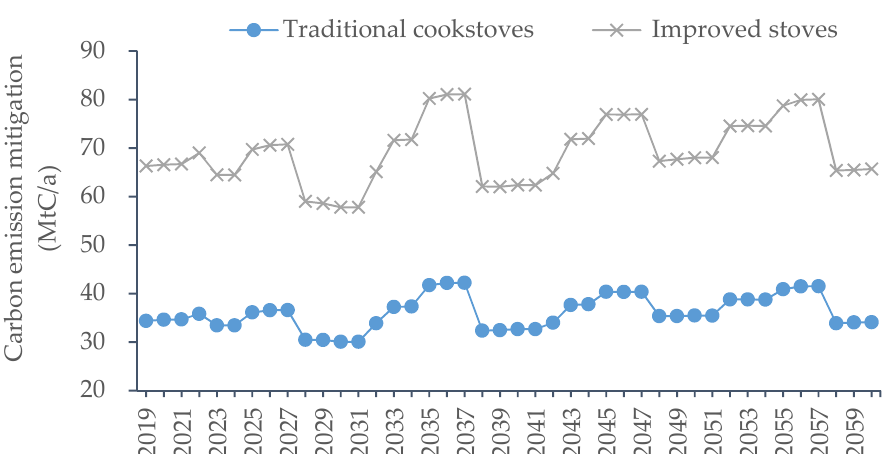
Figure 5. Carbon emission mitigation by forestry bioenergy of existing commercial forest.